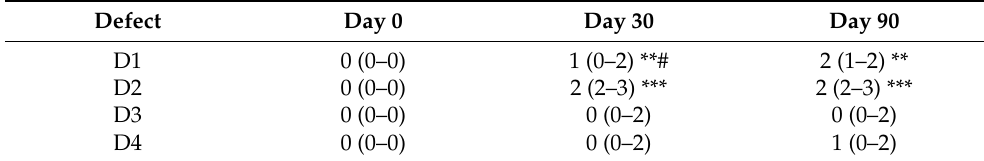
Figure 4. Serial 3D CT scans of calvarial bones of rats from the first experimental group after local EPO on collagen cone (D1) and local physiological saline on collagen cone (D2) application on post-operative days 0, 30 and 90. Table 3. Bone regeneration scores according to Patel et al. (2008) on day of surgery (day 0, n = 24) and postoperative days 30 ( n = 24) and 90 ( n = 12). Values are presented as median and minimum– maximum range.